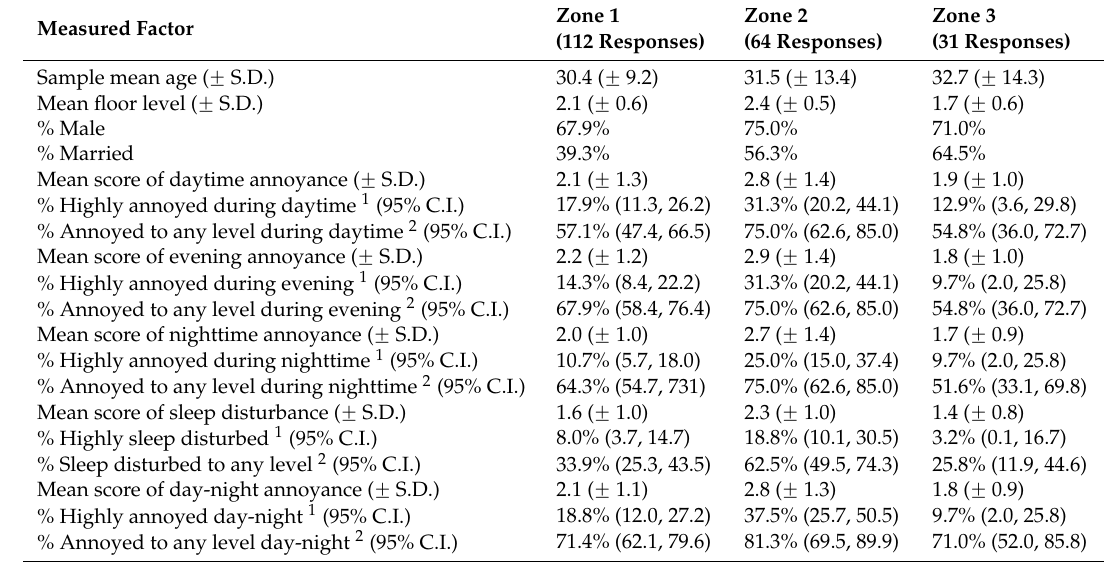
Table 4. Summary of the sampled residents' characteristics and traffic noise annoyance survey results. Measured